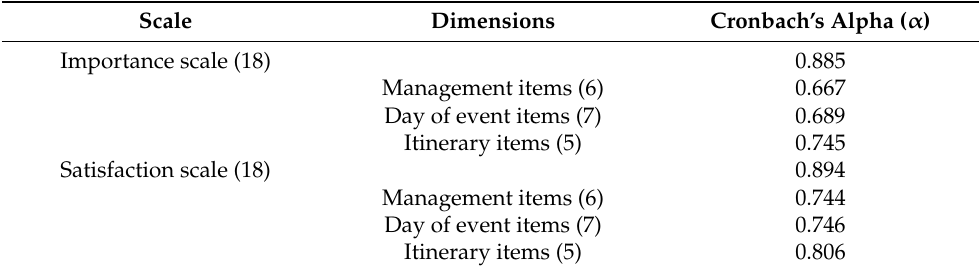
Table 1. Internal consistency of the IPA pilot study (n =